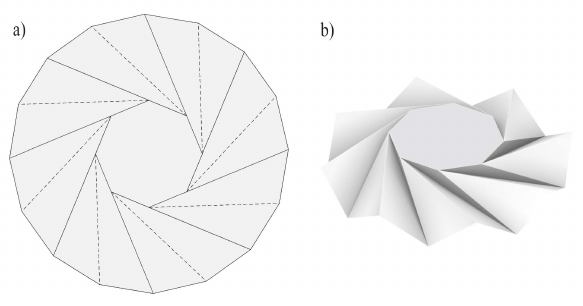
Figure 12: Physical model of an icosagon flasher in a) retracted and